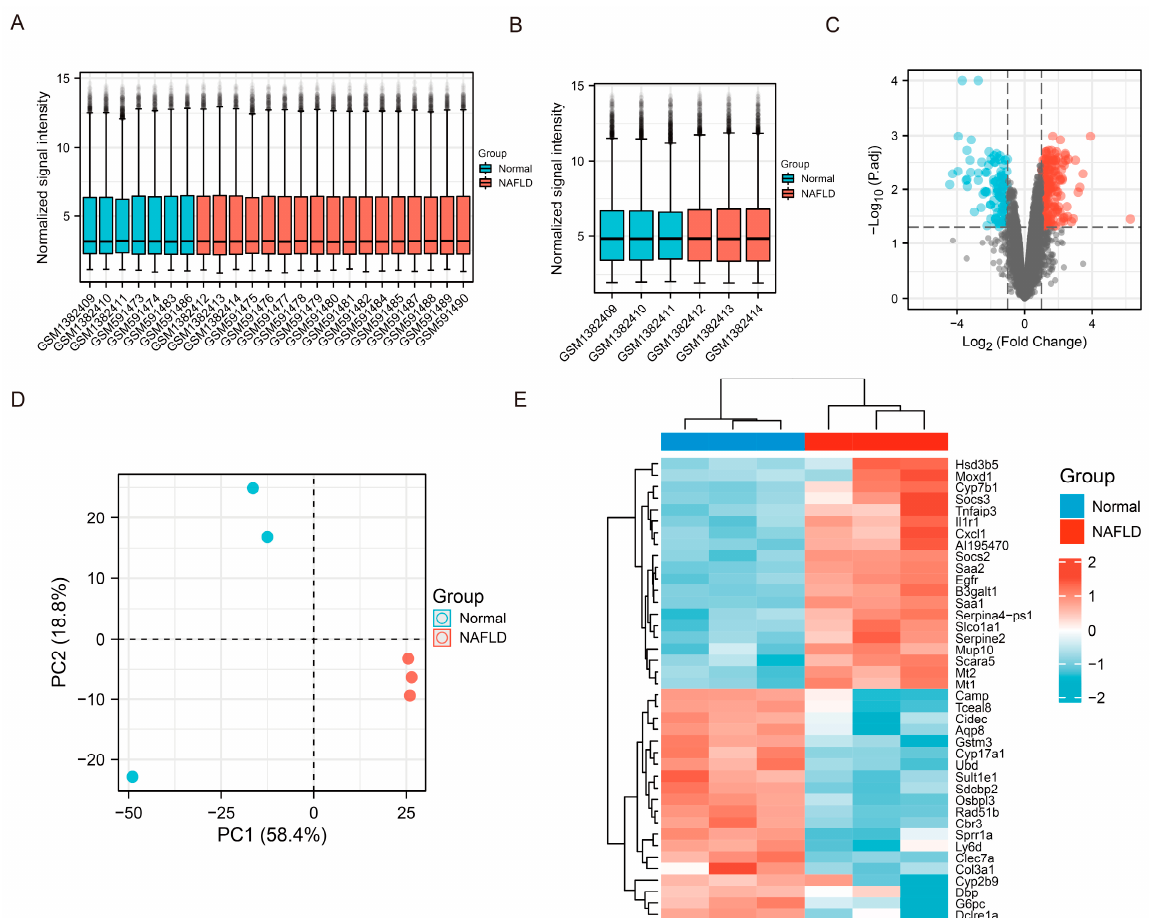
Figure 6. Mining and Analysis of GEO (Gene expression omnibus) database related to NAFLD. ( A , B ) The normalization of data sets (GSE151158 GSE57425). ( C ) Volcano plot of differential gene analysis (|logFC| > 1; p -value < 0.05). ( D ) Principal component analysis (PCA) of each group of samples in the GSE57425 data set. ( E ) Heat map of top 20 gene expressions (red: high expression; blue: low expression) in the expression profile. Data are shown as mean ±